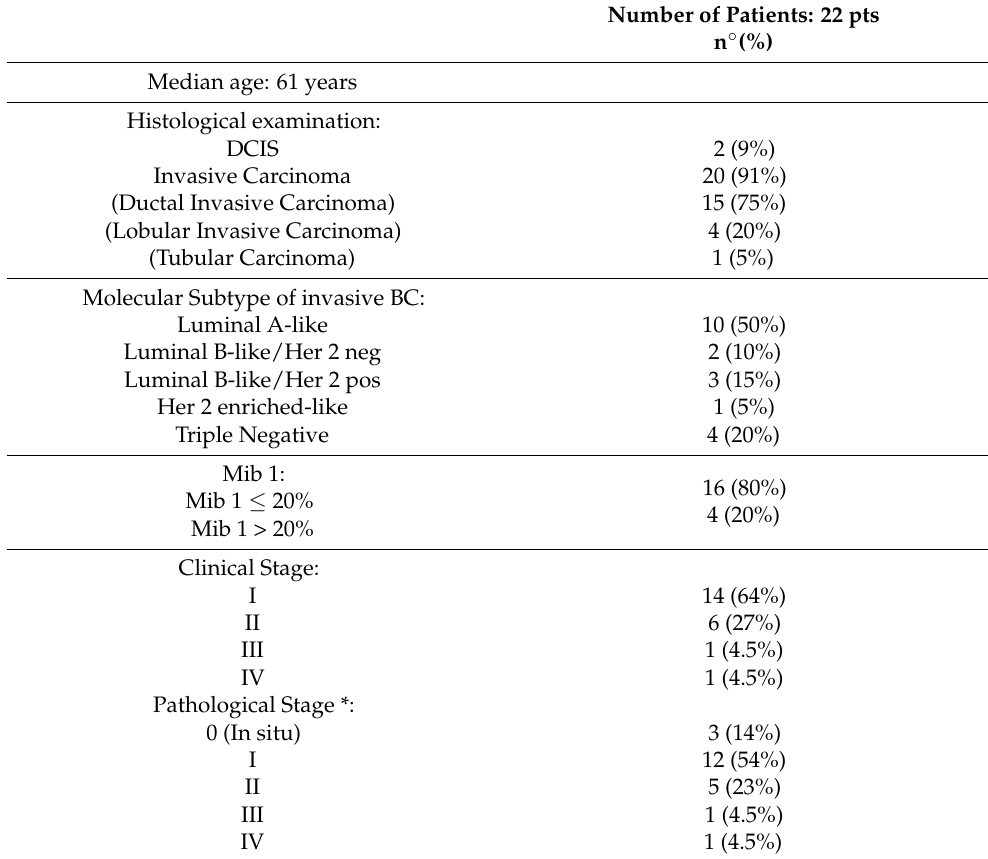
Table 1. Clinical-pathological features of BC patients affected by SSc with available BC samples. * For pathological stage patients subjected to neoadjuvant treatment were